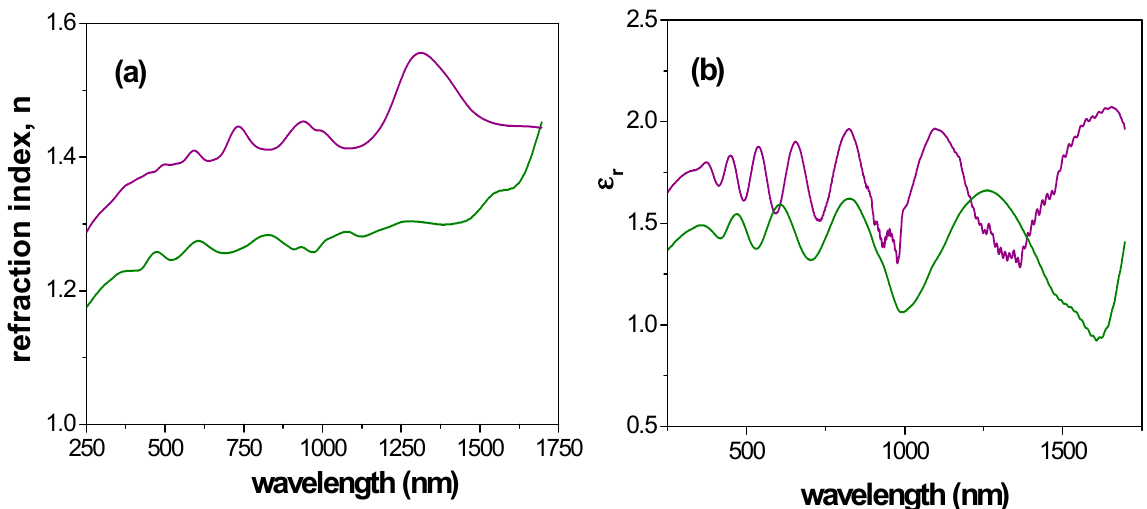
Figure 12. Wavelength dependence of: ( a ) refractive index; ( b ) real part of dielectric constant. Sample Ox+SiO 2 /APTES: solid green line, Ox+SiO 2 /APTES/O 3 : solid purple line.